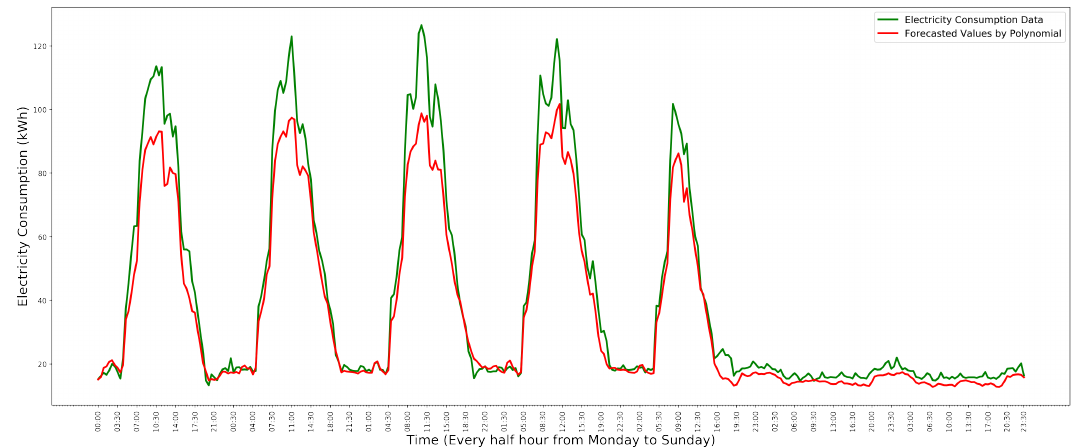
Figure 5. Predicted values a week. Adapted from